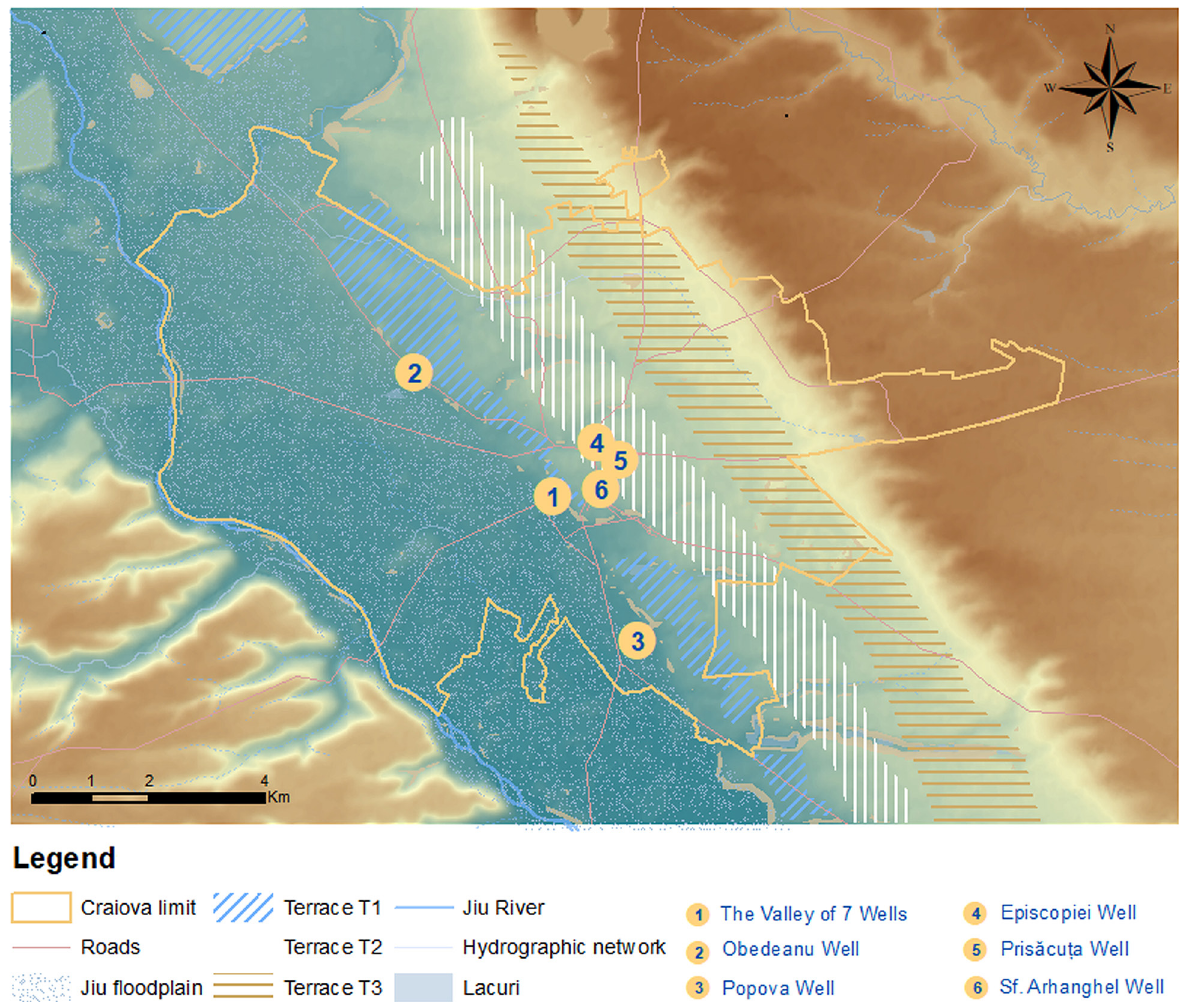
Fig. 2. The secular Wells positioning on the current map of Craiova